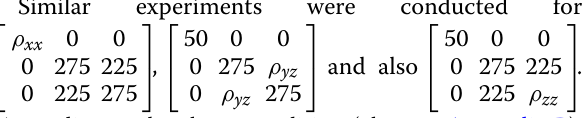
model as in Fig. 6. The influence of ρ yy in this case is shown in Fig. 7b.